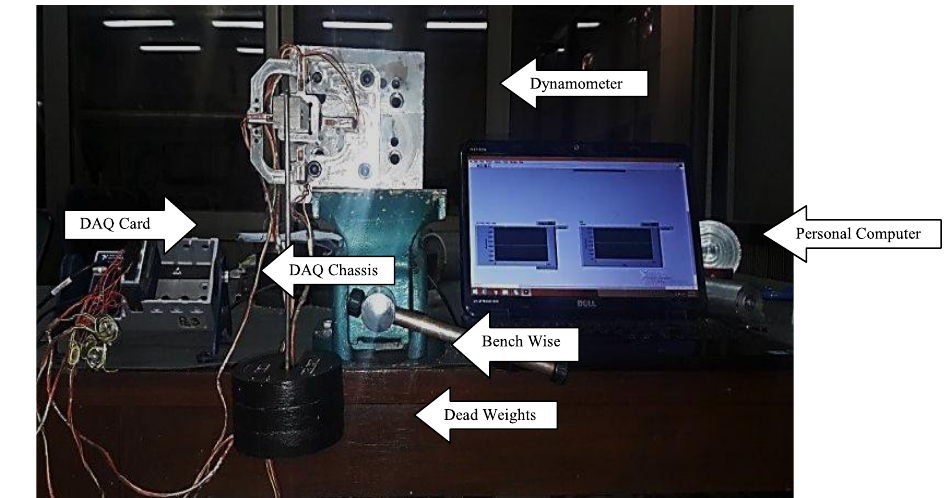
FIG. 3. FABRICATED DYNAMOMETER WITH INSTALLED STRAIN GAUGES